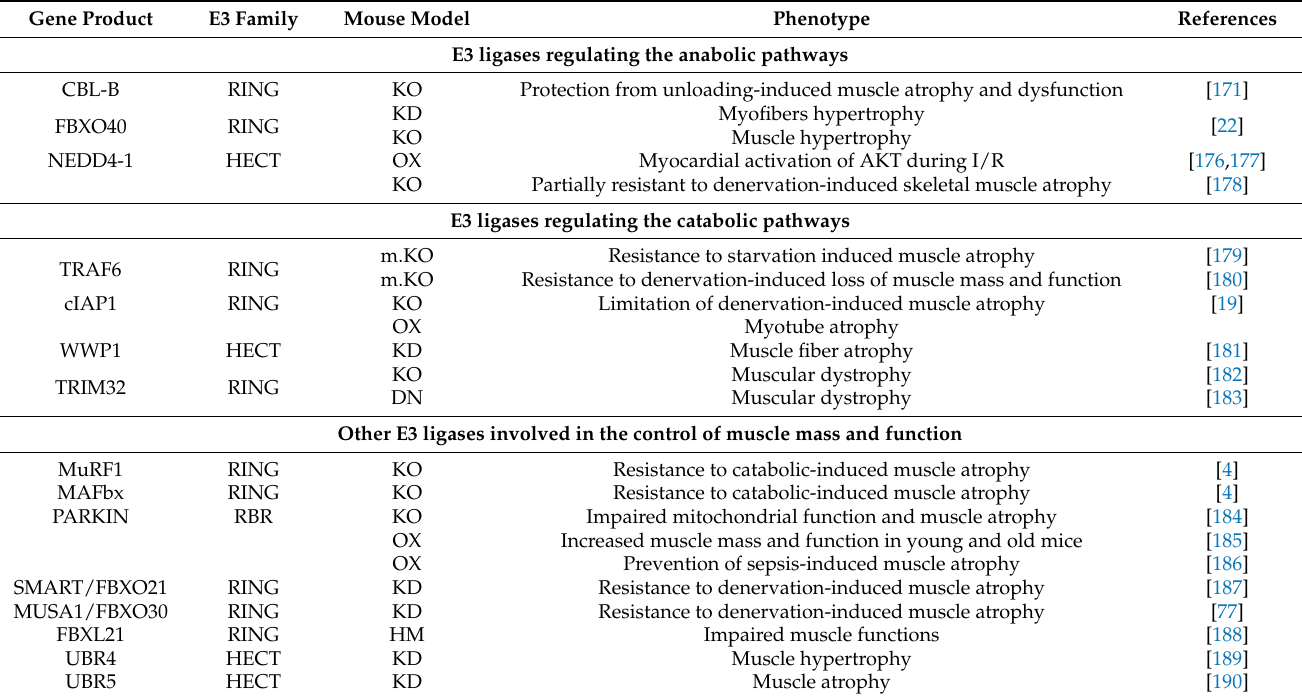
Table 1. Phenotypes of transgenic mice for genes encoding ubiquitin ligases involved in the control of muscle mass and